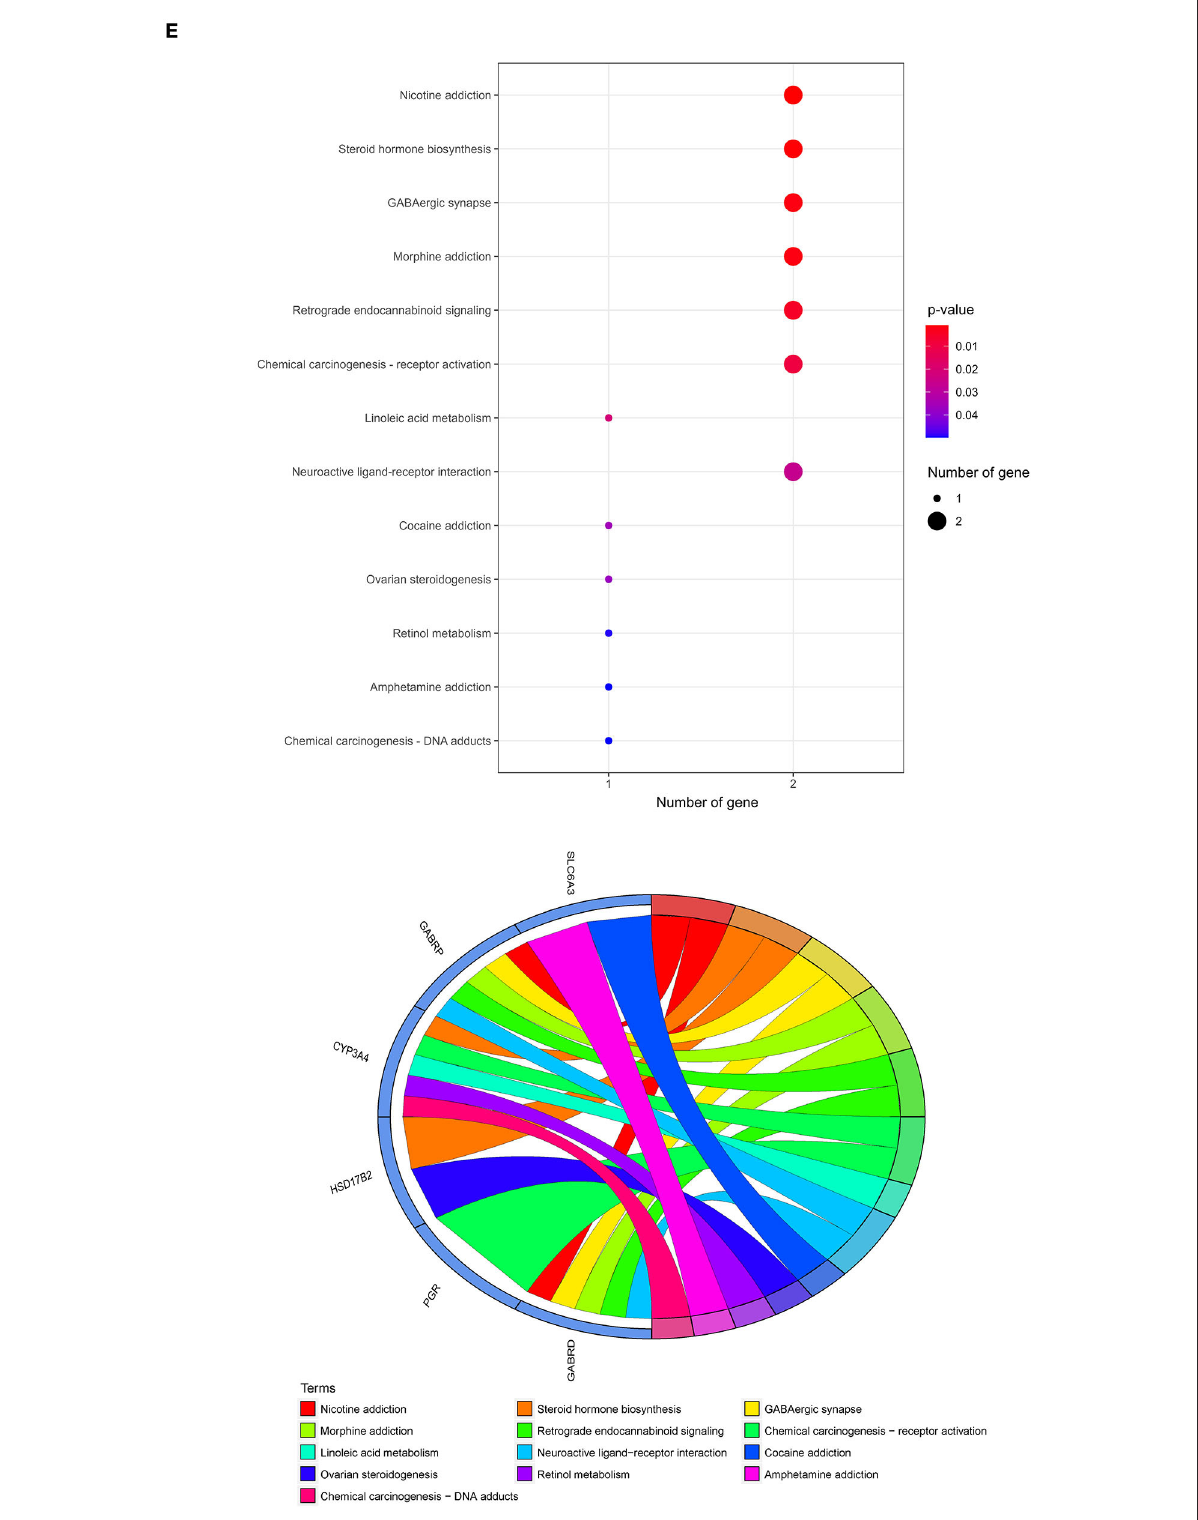
FIGURE3 Functional characterization of curcumol’s targets against COVID-19 and colon adenocarcinoma. The bubble plot highlights the involvement of curcumol’s targets in biological processes related to (A) fat and steroid hormone biosynthesis, (B) gland development, and (C) steroid binding and ion channel activity. (D) Gene ontology showed the occurred cell components. (E) KEGG enrichment analysis showed the contribution of curcumol’s targets in cell signaling pathways of carcinogenesis. The size of the bubble represents the number of genes. The color of the bubble represents the significance of the